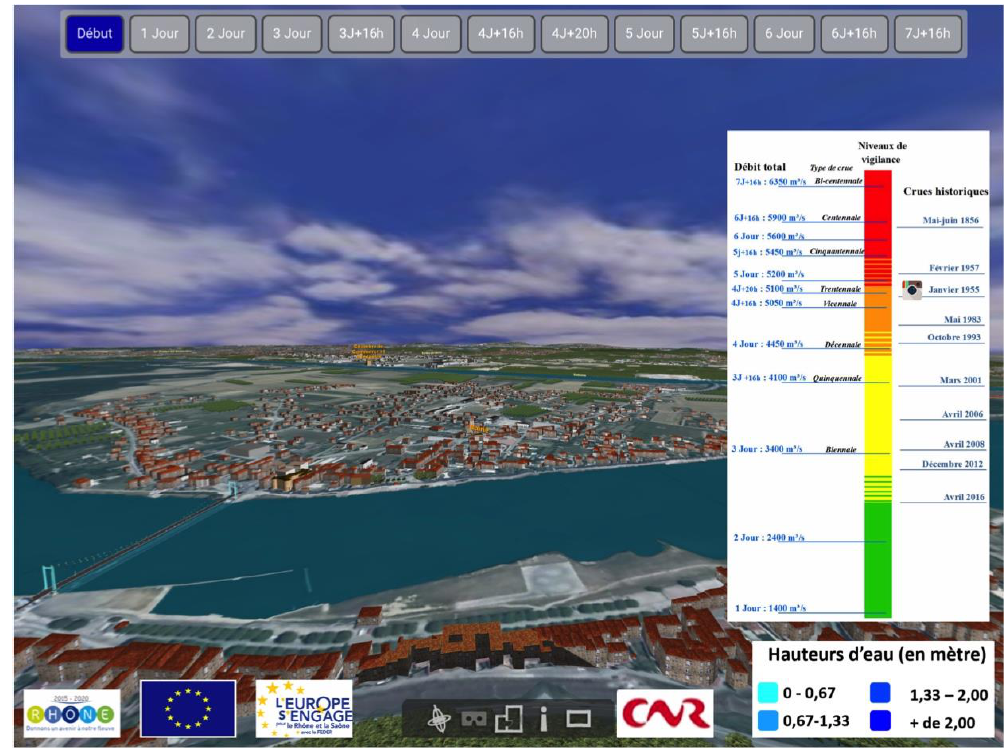
Figure 4. Interface proposed to the public on tablets for the visualization of the simulated flood from a chosen point of view. At the top is a temporal navigation panel to choose a point in the timeline of the simulated flood. On the right is a panel that can be hidden or displayed and that provide a link between water flow (m 3 per second) and historical floods that have occurred on the territory. It also enables the user to access historical pictures for some historical floods. At the bottom is a spatial navigation panel to go to the left or right, look up or down and zoom in or out. The information tool gives more details on how the flood was simulated.